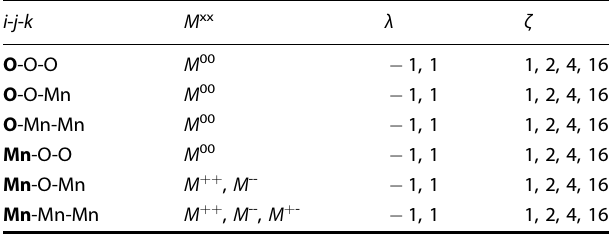
Table 3. Employed angular